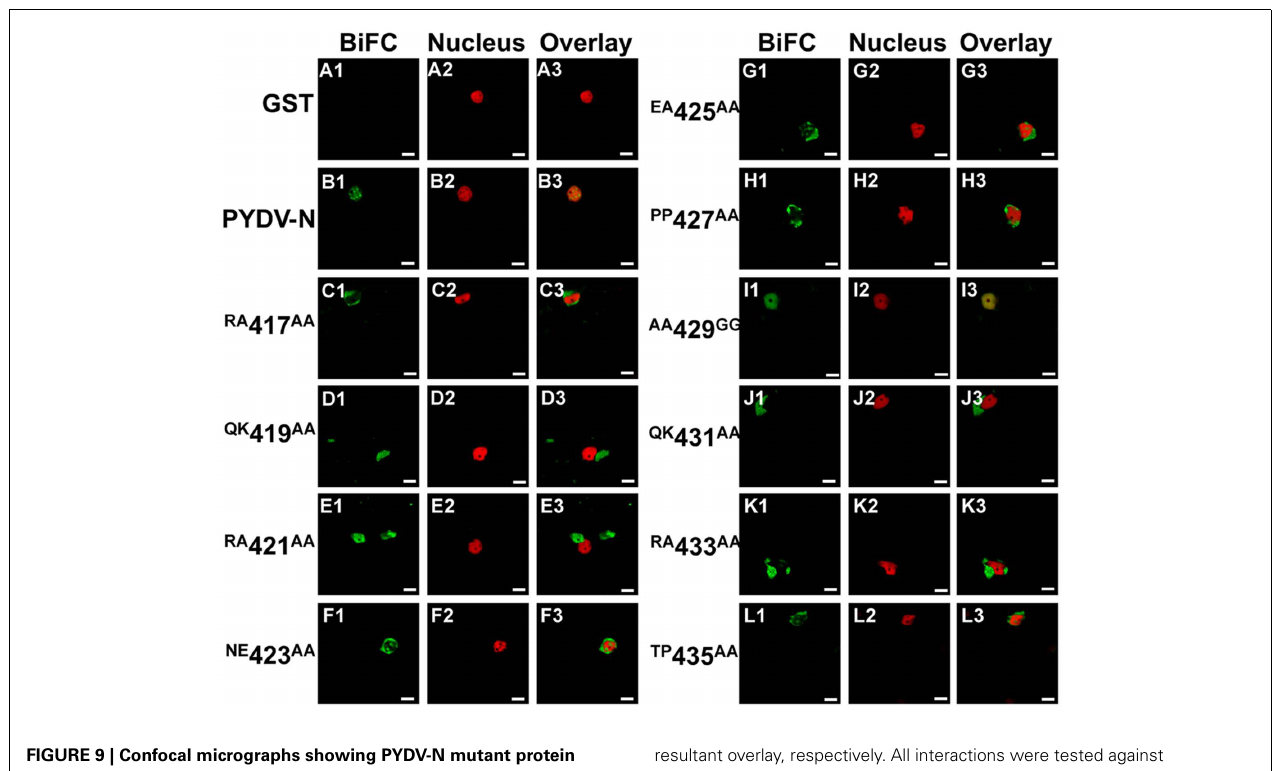
FIGURE 9 | Confocal micrographs showing PYDV-N mutant protein interactions with PYDV-P determined by BiFC. Interaction assays were conducted in leaf epidermal cells of transgenic N. benthamiana expressing a fluorescent nuclear marker protein fusion. Panels 1, 2, and 3 show micrographs ofYFP (BiFC), nuclear marker (Nucleus), and the